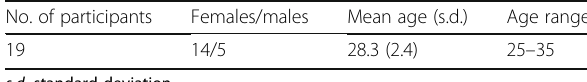
Table 3 Percentage distribution of phasic, tonic, and mixed sMMA events over each recording night